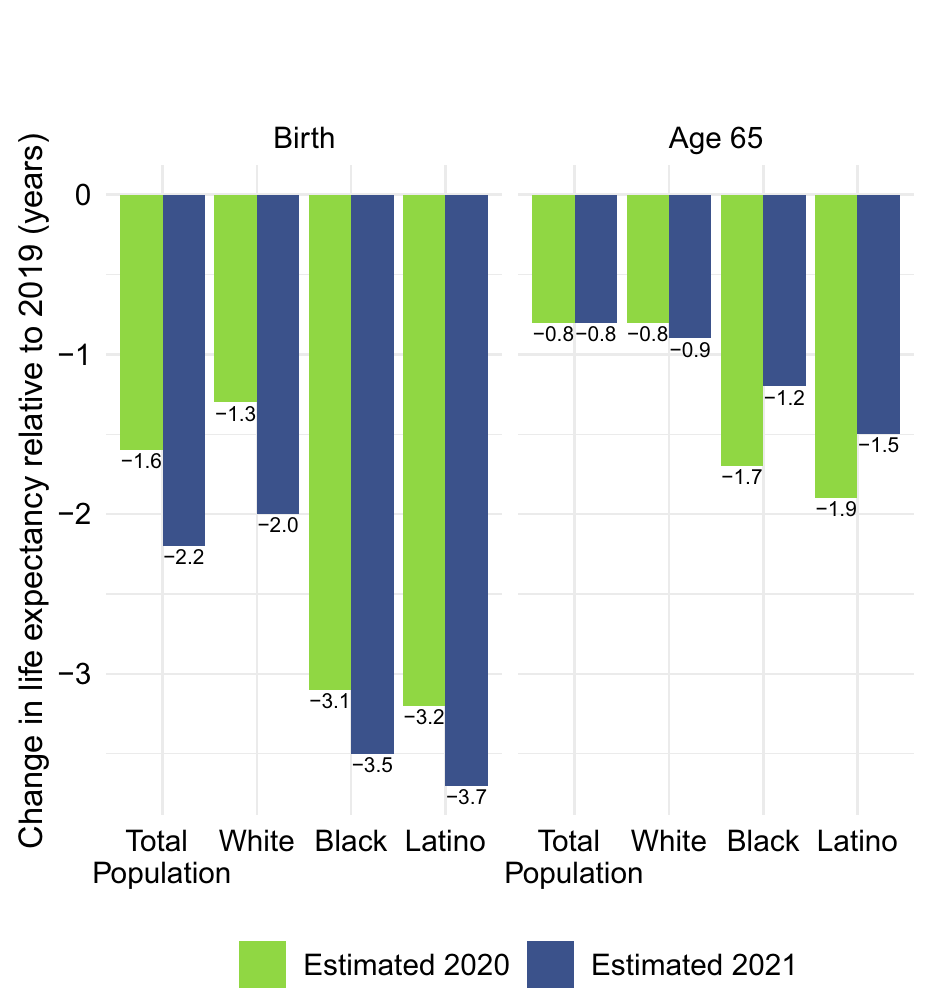
Fig 4. Change in life expectancy at birth and at age 65 (years) relative to 2019 by race/ethnicity, 2020 and 2021. Changes are all relative to 2019 life expectancy. Data are from CDC WONDER (July 6, 2022, update).